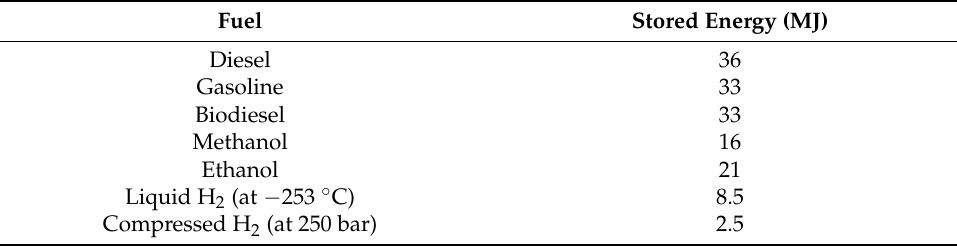
Table 10. Energy stored per liter of fuel